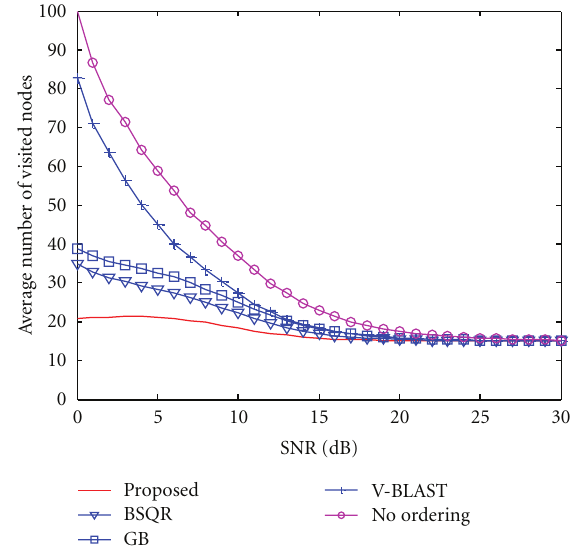
Figure 2: Complexity comparison under five ordering schemes for 4 × 4 16QAM system.